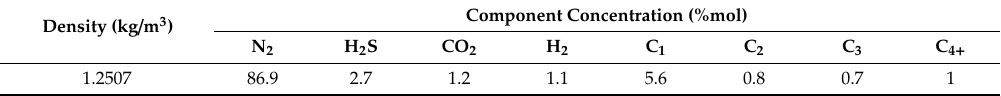
Table 2. Simplified composition of high-nitrogen natural